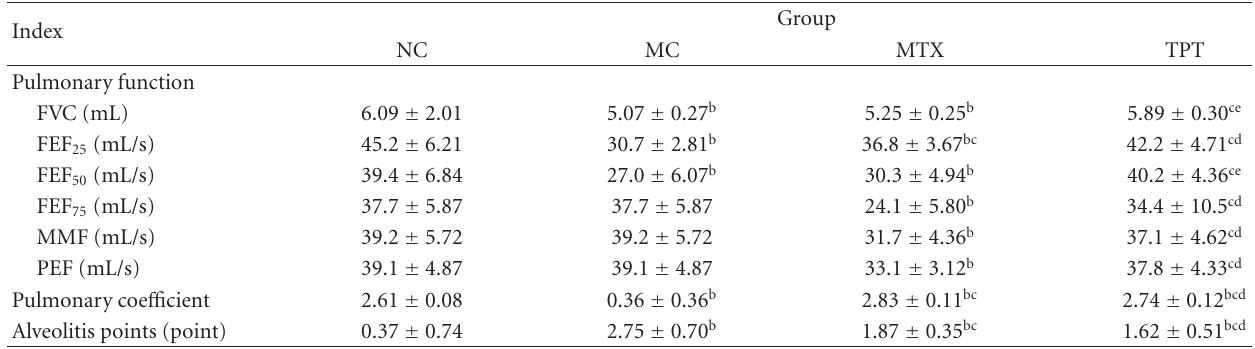
Table 1: Comparisons of pulmonary function, pulmonary coe ffi cient, and alveolitis in rats ( n = 12, x ± s ).